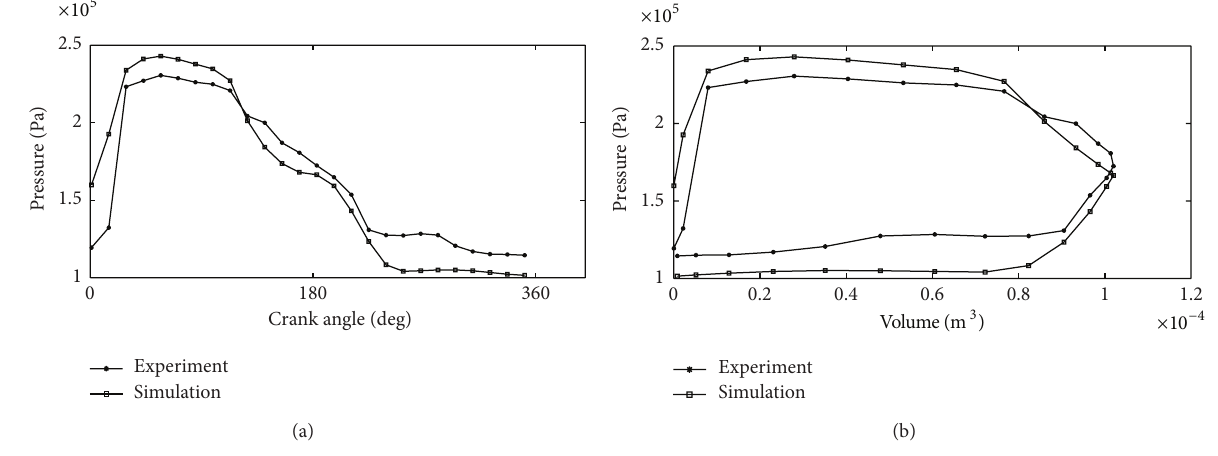
Figure 6: Experimental and simulation curves of cylinder pressure.